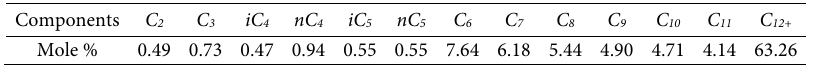
Table 1. Compositional analysis of the crude oil Table 1: Compositional analysis of the crude oil